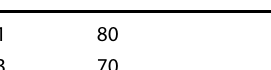
Table 2 Reaction time variation with different catalyst (MVPA/Kaolin) loads for oxidation/degradation of Chromotrope 2R in the presence of hydrogen